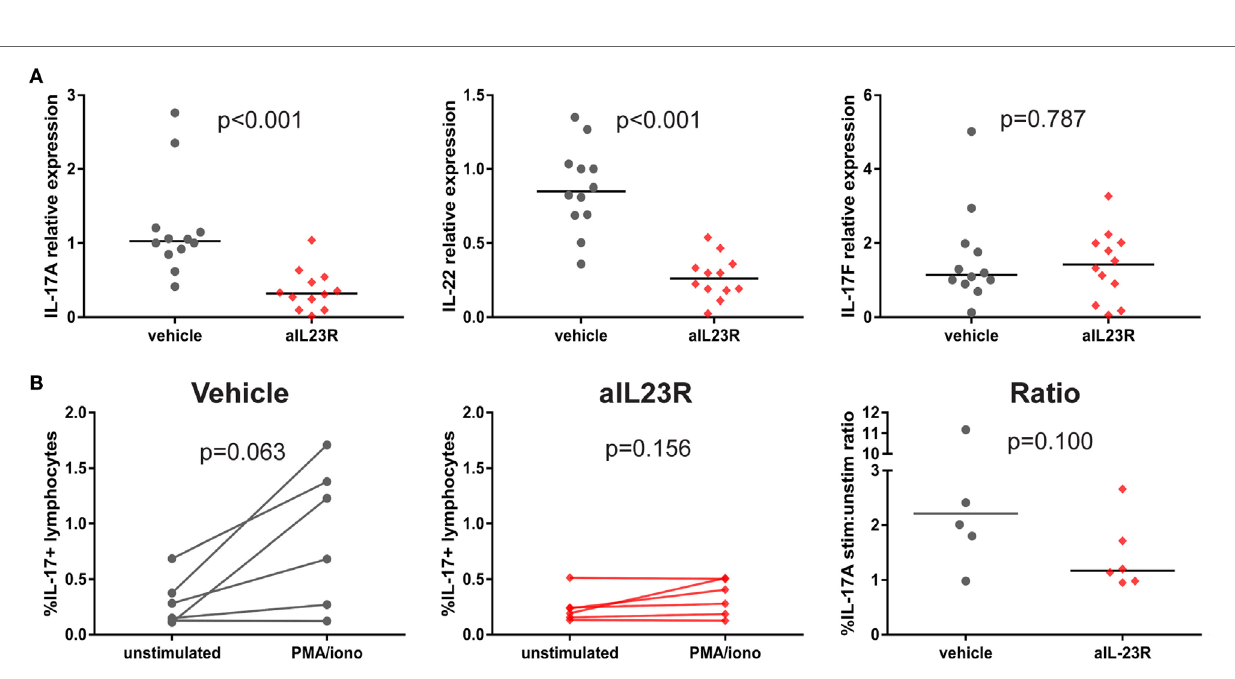
FigUre 3 | Histological analysis of peripheral and axial joints after therapeutic anti-IL23R treatment. Ankle and spinal sections from HLA-B27 tg rats were histologically stained and semiquantitatively examined for inflammation, destruction, new bone formation, and ectopic foci of hypertrophic chondrocytes (individual data points for each ankle joint or spinal sample and median are